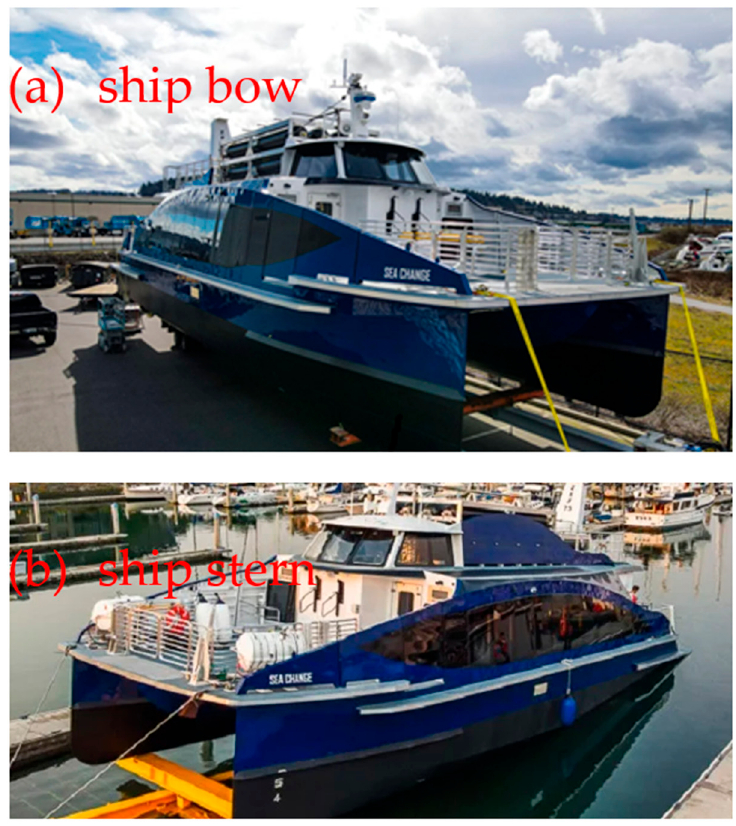
Figure 3. The ship “Sea Change” [27,28].